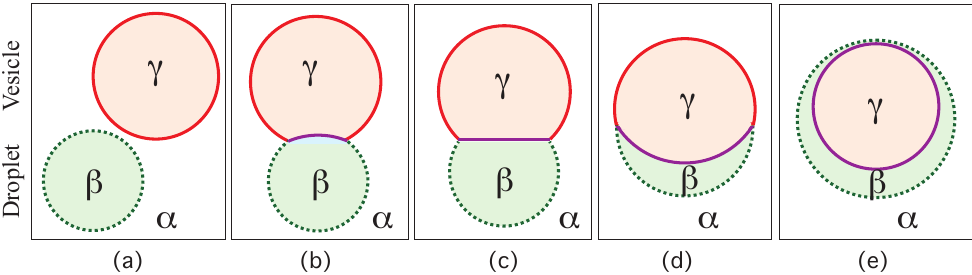
Figure 2. Different adhesion morphologies of a lipid vesicle (light red) interacting with a condensate droplet β (light green) that coexists with the bulk phase α (white): ( a ) Complete dewetting and ( b ) partial dewetting of the vesicle membrane (red/purple) by the condensate droplet β ; ( c ) Balanced pressure between the β and the γ phase; ( c ) Partial wetting and ( d ) complete wetting of vesicle membrane by β droplet. As in Figure 1, all morphologies involve three aqueous phases, the liquid bulk phase α (white), the condensate phase β forming the droplet (light green), and the inert spectator phase γ (light red) within the vesicle. The contact area between droplet and membrane, which is equal to the surface area of the βγ segment (purple), increases from zero in ( a ) to the total membrane area in ( e